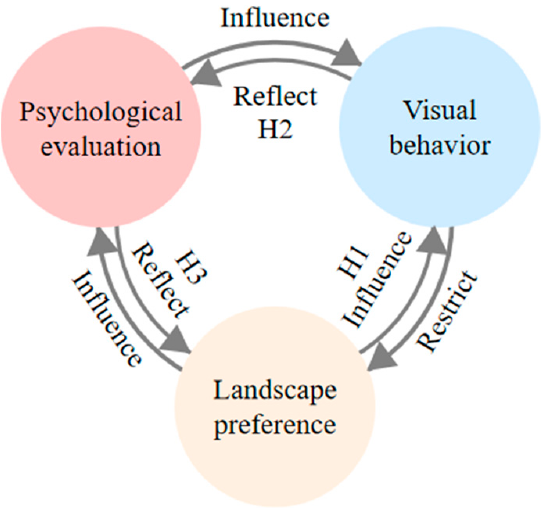
Figure 1. Research hypothesis diagram. This figure was created by the author. Hypothesis 1 (H1). There is a significant difference in the similarity of visual behavior characteris- tics of forest landscapes after repeated viewings for high- and low-preference landscapes, and there is a positive correlation between similarity and preference.